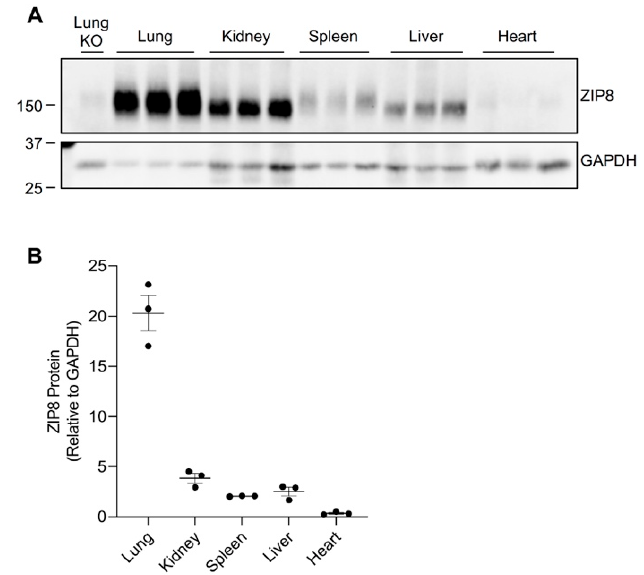
Figure 1. ZIP8 expression in the lung, kidney, spleen, liver, and heart of mice. Mouse tissues were collected from wild-type male mice at 3 weeks of age ( n = 3). ( A ) Tissues were analyzed by Western blotting with 120 µ g protein loaded per lane. The blot was probed with anti-mouse ZIP8 antibody for ZIP8 detection and HRP-conjugated GAPDH antibody as the loading control. The blot includes the lung tissue from a female, 6-week-old Zip8 -KO mouse as a control to validate the anti-mouse ZIP8 antibody. ( B ) For each tissue, the ZIP8 protein level was normalized to GAPDH.